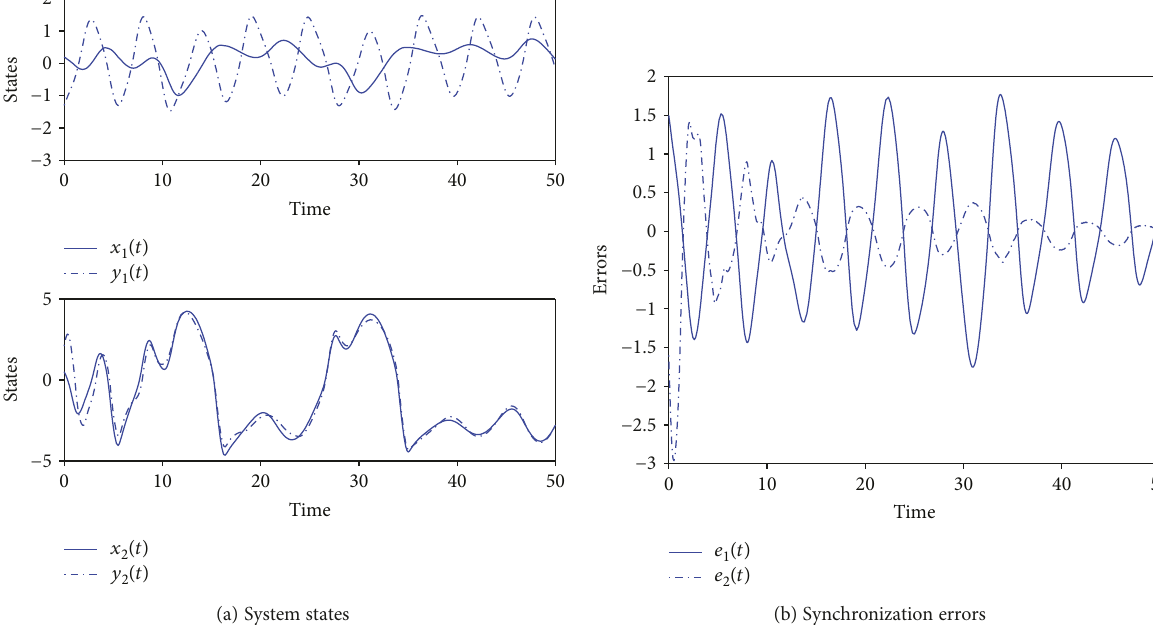
2 , and the synchronization